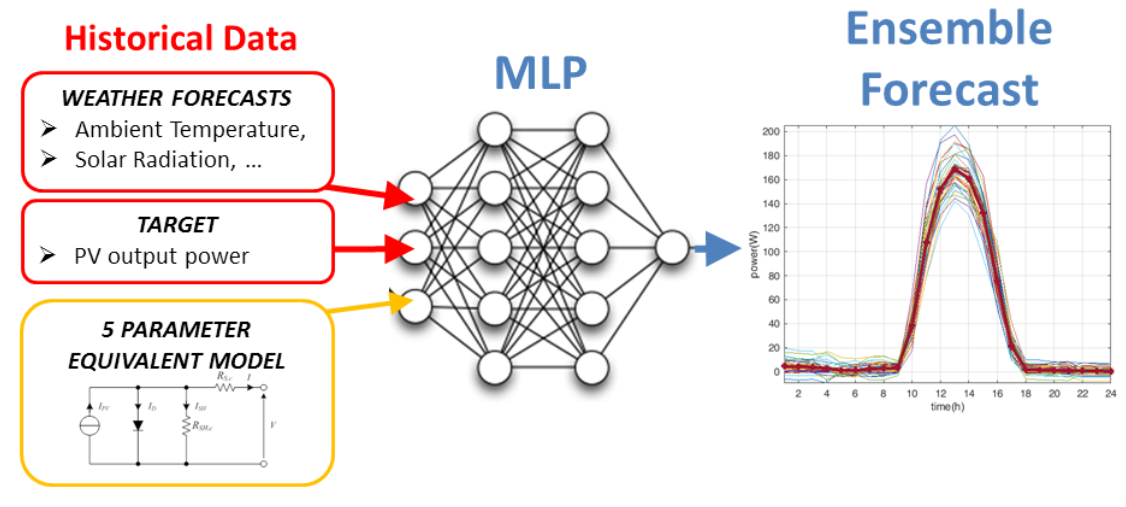
Figure 5. Schematic view of P5ANN (hybrid of a five-parameter equivalent model and the Artificial Neural Network): the network receives as inputs the weather forecast and the corresponding power output of the five-parameter models.